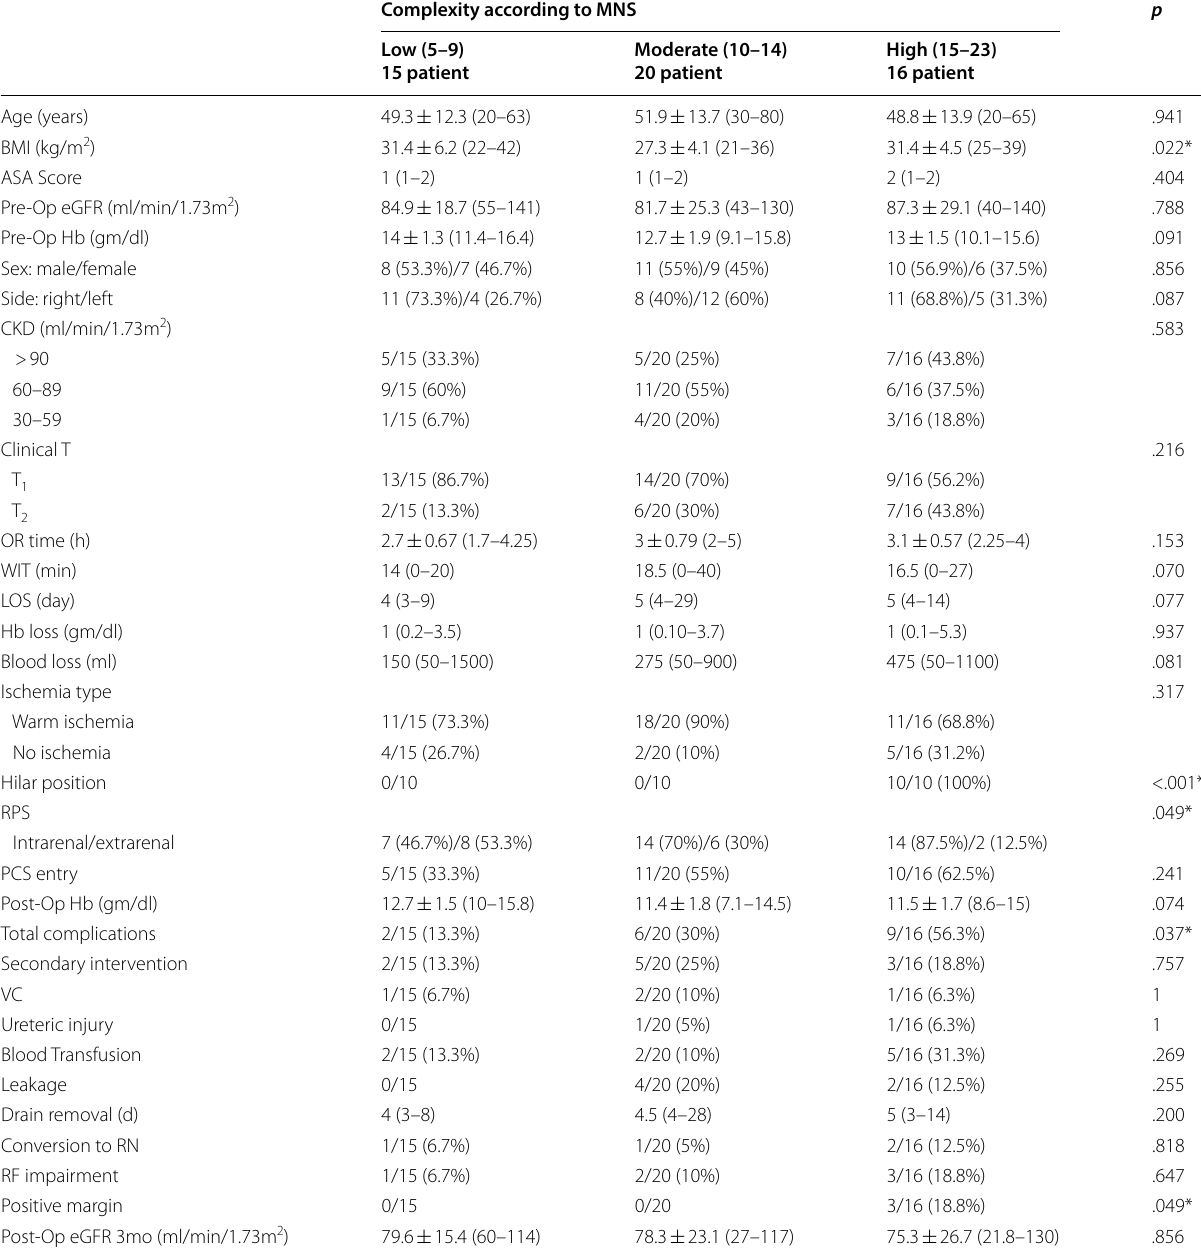
Table 4 Renal mass complexity according to newly modified score in relation to outcome